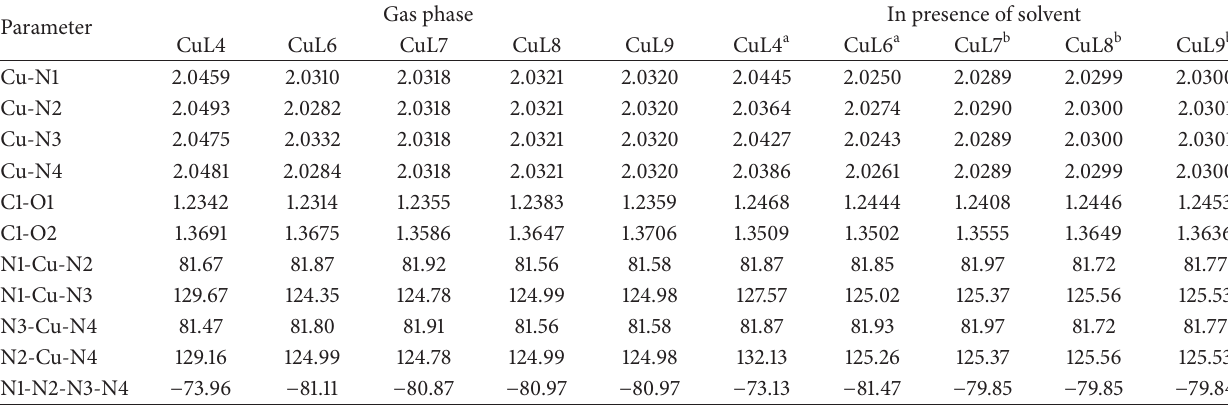
Table 1: Selected bond lengths (angstroms), bond angles, and dihedral angles (degrees) for copper complexes. Parameter